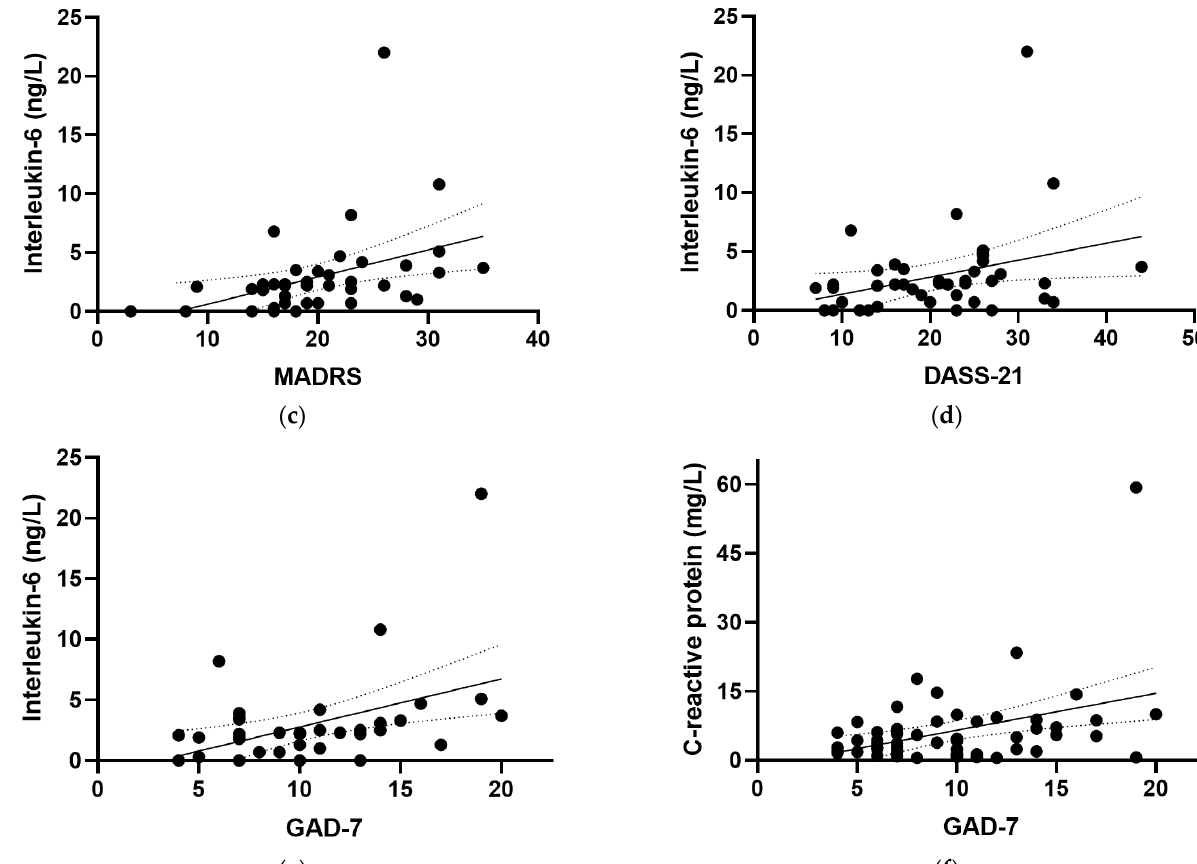
Figure 4. Correlations of inflammatory biomarkers with mood scores. Correlations of interleukin-6 with ( a ) the Edinburgh Postnatal Depression Scale (EPDS; r = 0.319, p = 0.04), ( b ) the Clinical Global Impressions—Severity Scale (CGI-S; r = 0.528, p < 0.001), ( c ) the Montgomery and Åsberg Depression Rating Scale (MADRS; r = 0.563, p < 0.001), ( d ) the Depression Anxiety Stress Scale 21 (DASS-21; r = 0.379, p = 0.015), and ( e ) the Generalized Anxiety Disorder-7 (GAD-7; r = 0.442, p = 0.005). ( f ) Correlation of C-reactive protein with GAD-7 ( r = 0.260, p = 0.05). Dashed lines indicate 95% confidence intervals.